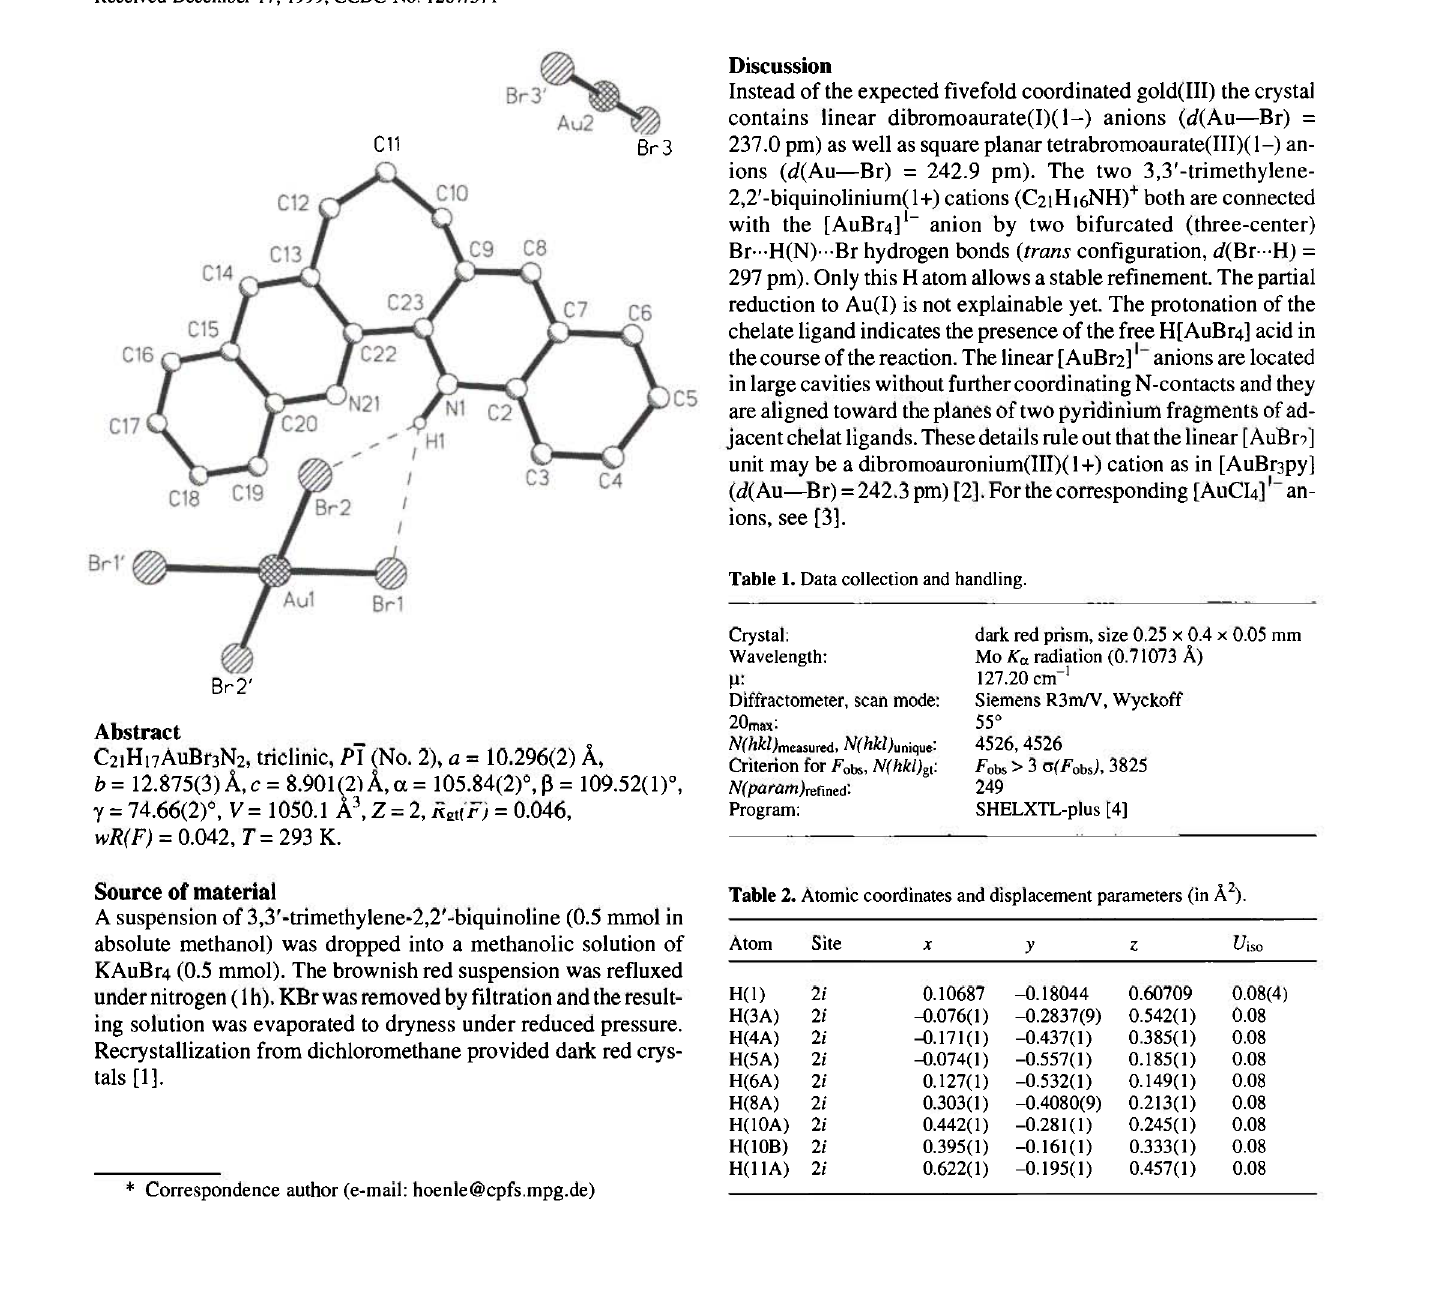
Table 2. Atomic coordinates and displacement parameters (in Ä 2